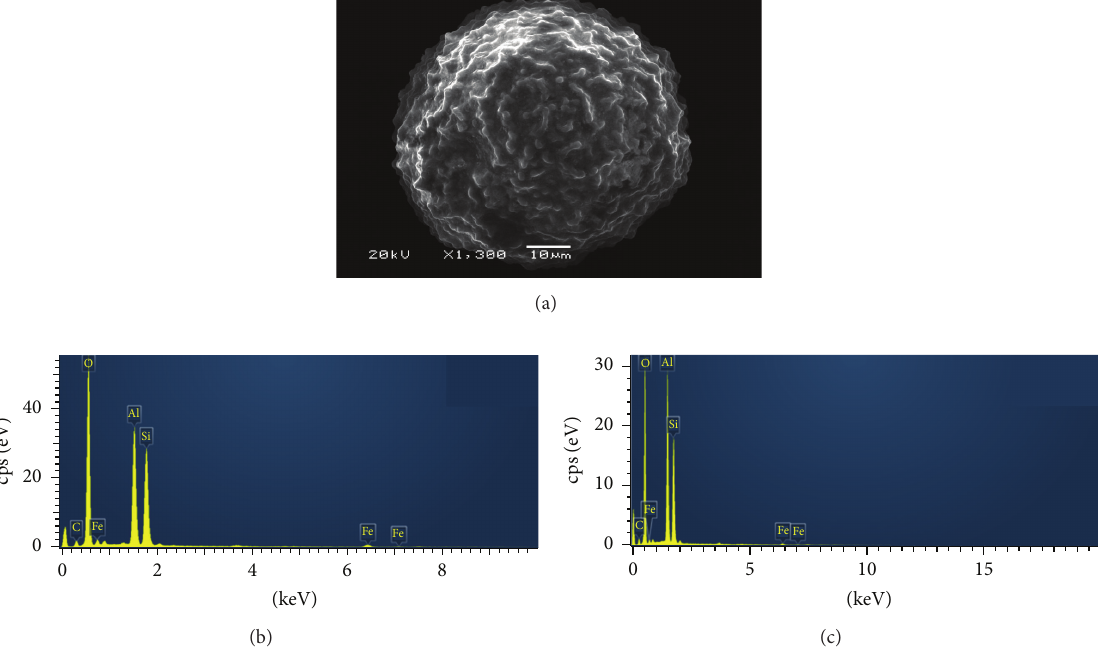
Figure 2: Distributions of Fe on the surface of E-catalyst with (a) catalyst with high iron content; (b) element analysis of iron nodule; (c) element analysis of smooth surface.